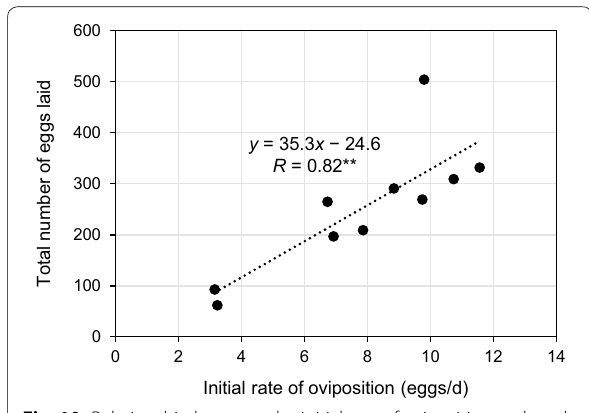
Fig. 10 Relationship between the initial rate of oviposition and total number of eggs laid. (**) correlation significant at 0.01 level